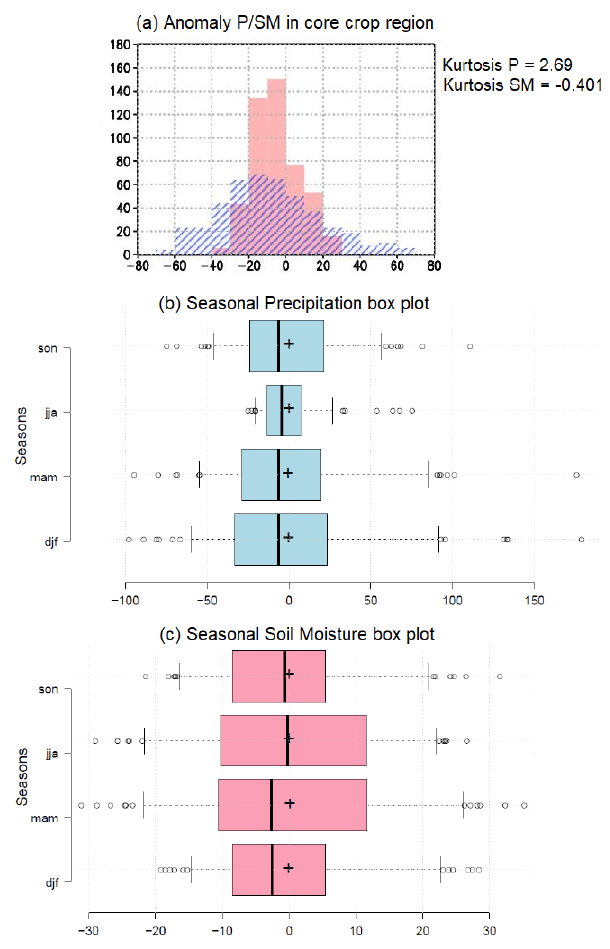
Figure 5. Frequency histograms in the core crop region and kur- tosis values for (a) precipitation anomalies (blue; hatched) and soil moisture anomalies (light red). (b) Box plots of seasonally averaged time series inside the core crop region for precipitation anomalies. (c) Same as (b) but for soil moisture anomalies (light red). All com- putations were done from January 1979 to December 2018.